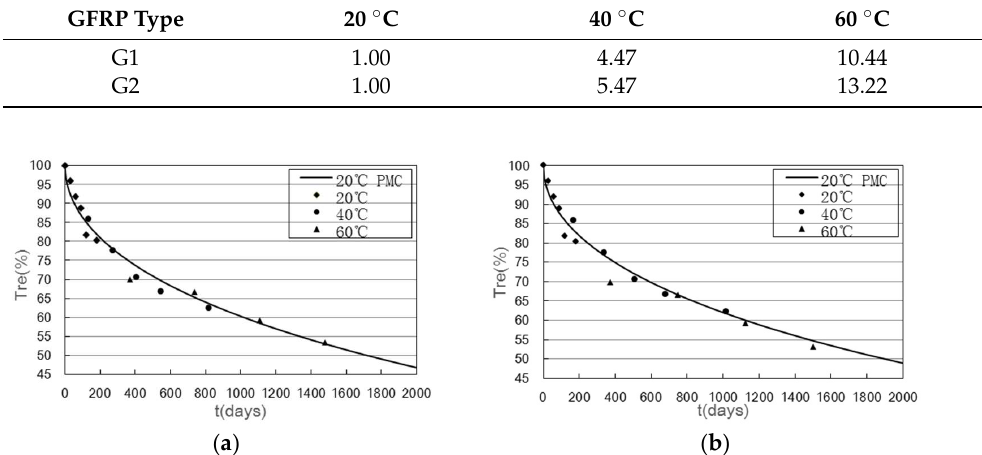
Figure 23. Estimated data and test data at 20 °C, with the curve for 20 °C by the third model: ( a ) G1; ( b ) G2.